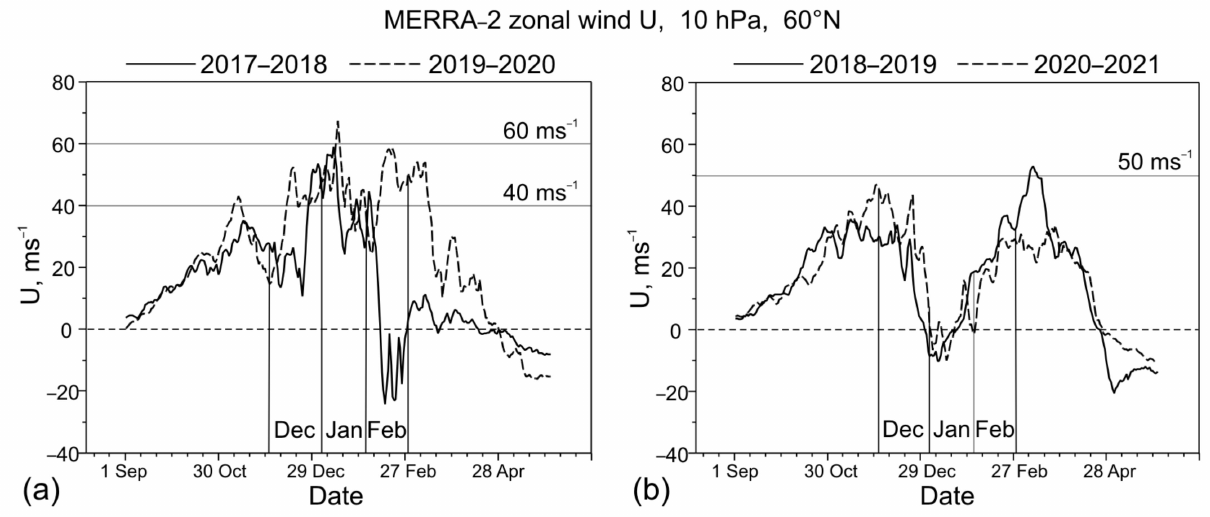
Figure A1. MERRA-2 zonal wind at 10 hPa, 60 ◦ N, in winters of ( a ) stronger vortex and ( b ) weaker vortex. Note absence of zonal wind reversal in winter 2019–2020 as seen from the dashed curve in ( a